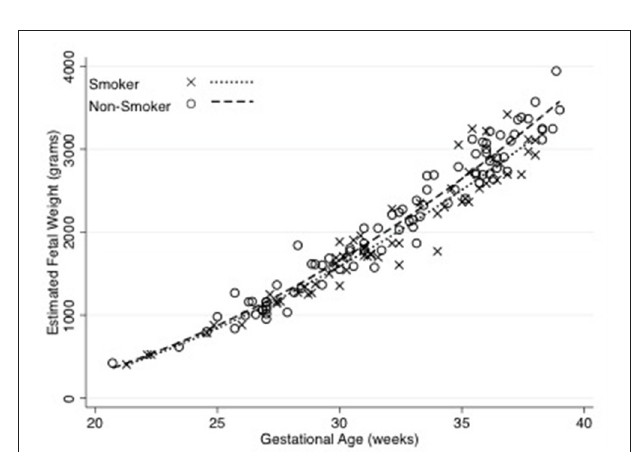
FIGURE 5 | Estimated fetal weight throughout gestation by smoking status of the mother. The relationships between fetal growth and gestation were derived using non-linear regression. Equations are: Smokers = 1165.78–135.23 (Gestational Age) + 4.96 (Gestational Age 2 ) ( R 2 = 0.93), Non-smokers = − 282.37–47.64 (Gestational Age) + 3.75 (Gestational Age 2 ) ( R 2 = 0.96). Number of observations for smokers = 62 and Non-smokers =